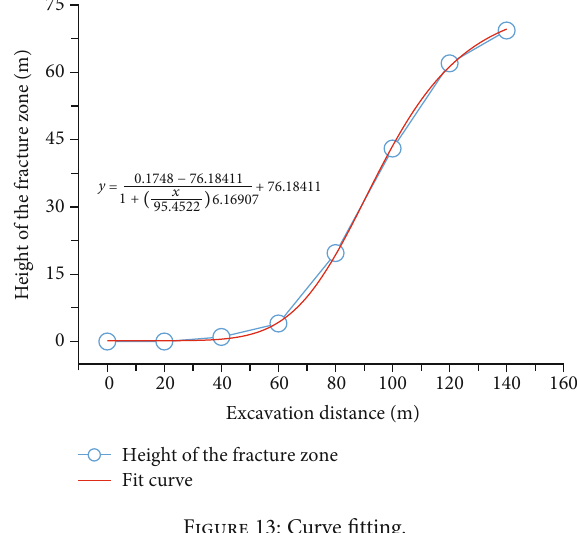
Figure 13: Curve fi